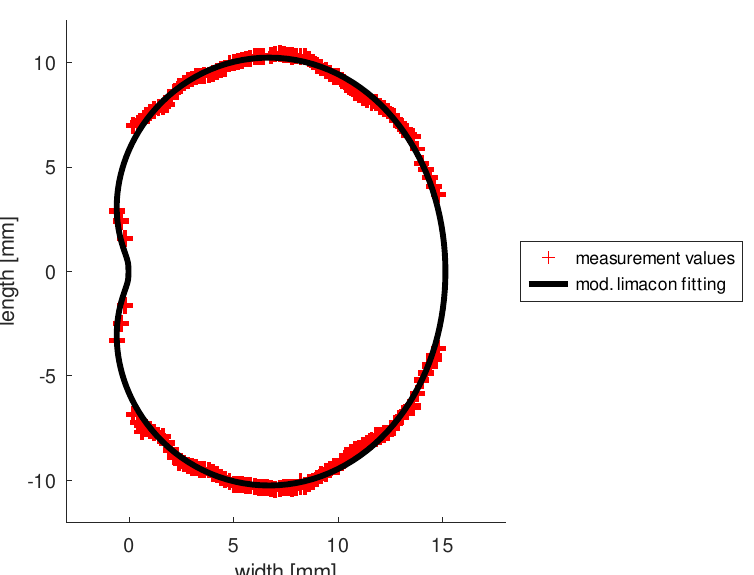
Figure 1. The shape of the human vitreous described with a mathematical function, the modified Limacon, obtained by fitting the US measurement data from 12